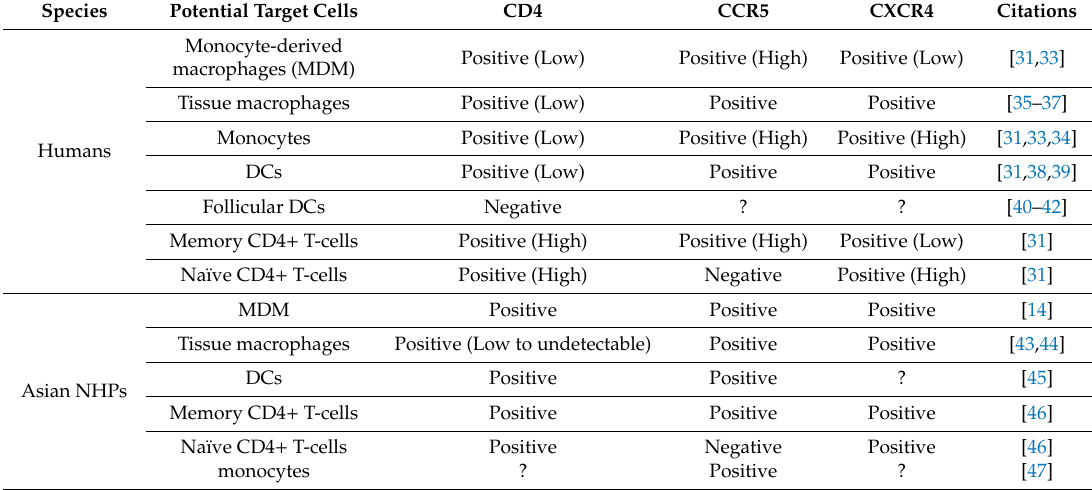
Table 1. Receptor and coreceptor expression on a subset of myeloid lineage cells and CD4 + T cells from humans and Asian